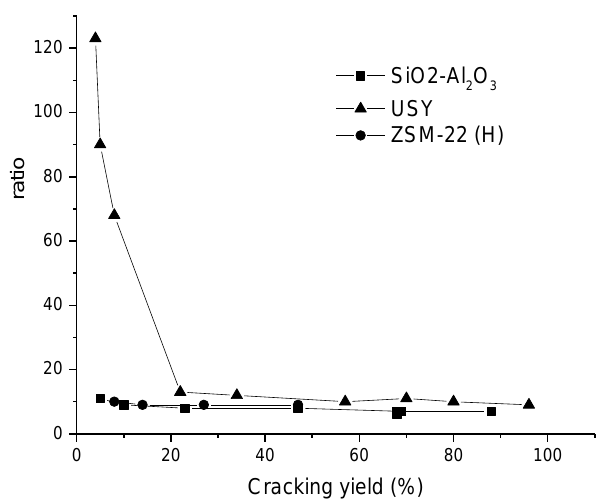
Figure 9. The ratio between mono- to dibranched isomers as a function of cracking in pristane hydroisomerization over Pt-supported silica alumina, USY, and hierarchical H-ZSM-22 catalysts [21]. Reproduced with permission from Martens et al., Catal. Today ; published by Elsevier, 2013